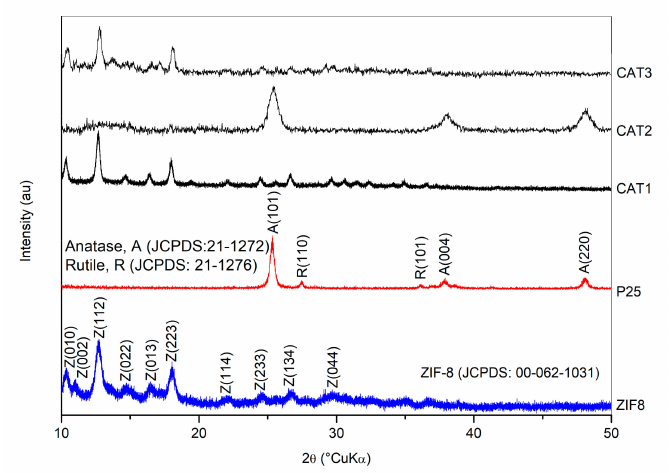
Figure 1. XRD patterns of the studied series of samples.